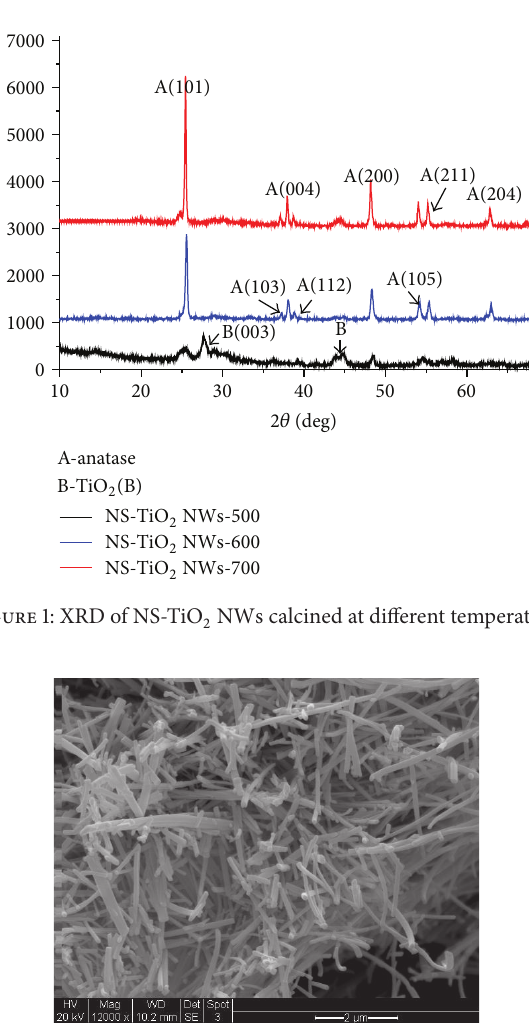
Figure 2: SEM image of NS-TiO 2 NWs.